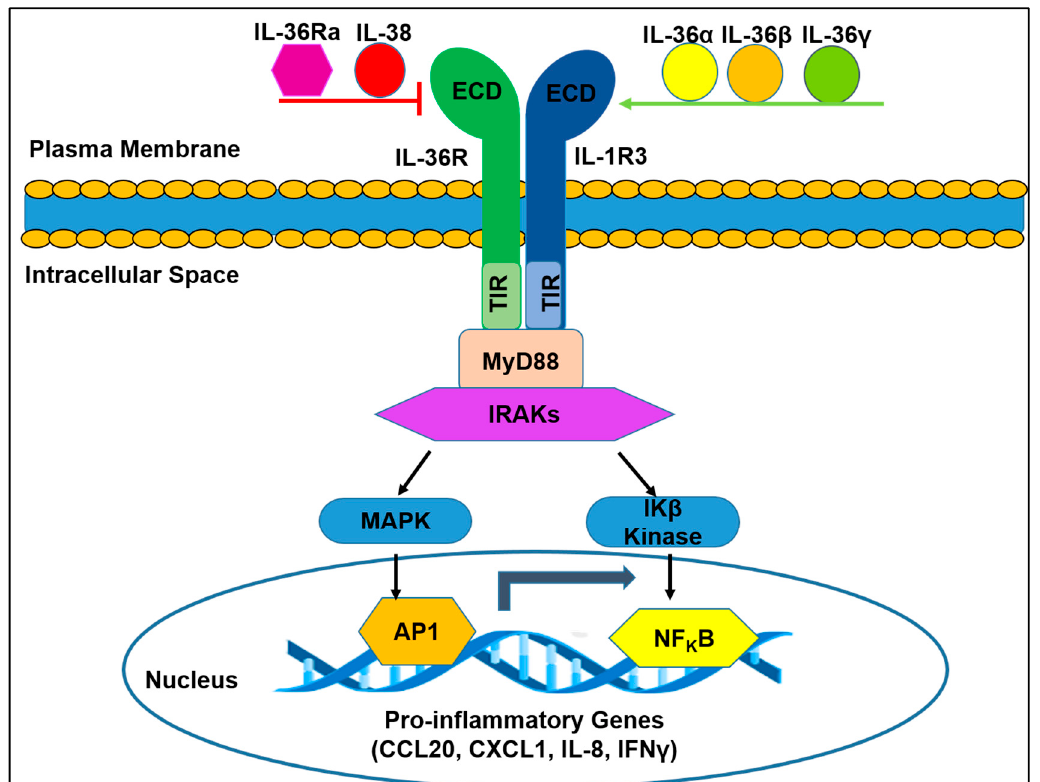
Figure 1. Structural and molecular depiction of interleukin 36 receptor (IL-36R) signaling cascade. Upon binding to its agonists (IL-36 α , IL-36 β , or IL-36 γ ), IL-36R heterdimerizes with its co-receptor IL-1R3 (IL-1RAcP). The formation of the IL-36R / IL-36 / IL-1R3 complex results in the recruitment of MyD88 and IRAKs, which subsequently activates the MAPK and NFKB pathways. Activation of MAPK results in the transcription of inflammatory genes regulated by AP-1, while the phosphorylation of IK βα (a negative regulator of NF K B) by Ik β kinase leads to the translocation of NF K B to the nucleus, which aids in the transcription of genes important for mediating inflammation. The IL-36R mediated activation of pro-inflammatory gene expression can be inhibited by IL-36Ra or IL-38. Extracellular domain (ECD), toll / interleukin-1 receptor domain (TIR), myeloid di ff erentiation primary response 88 (MyD88), interleukin-1 receptor associated kinases like 1 and 2 (IRAKs), mitogen-activated protein kinase (MAPK), activator protein-1 (AP-1), NF-Kappa-B Inhibitor Alpha (IK βα ), and nuclear factor kappa light chain enhancer of activated B cells (NF K B), CCl, C-C motif chemokine ligand; CXCL, C-X-C motif chemokine ligand; IFN,